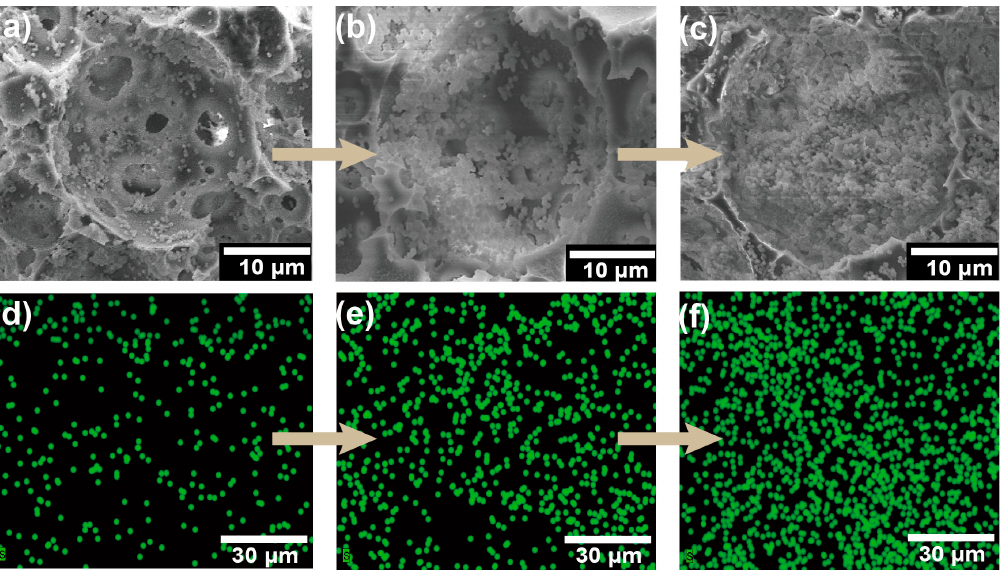
Figure 4. SEM images of P. acidilactici immobilized PHI-1090 ( a ), P. acidilactici immobilized PHI-1090 after one cycle fermentation ( b ), and P. acidilactici immobilized PHI-1090 after 10 cycle batches ( c ). ( d – f ) were sulfur element EDS images, corresponding to ( a – c ), sequentially.